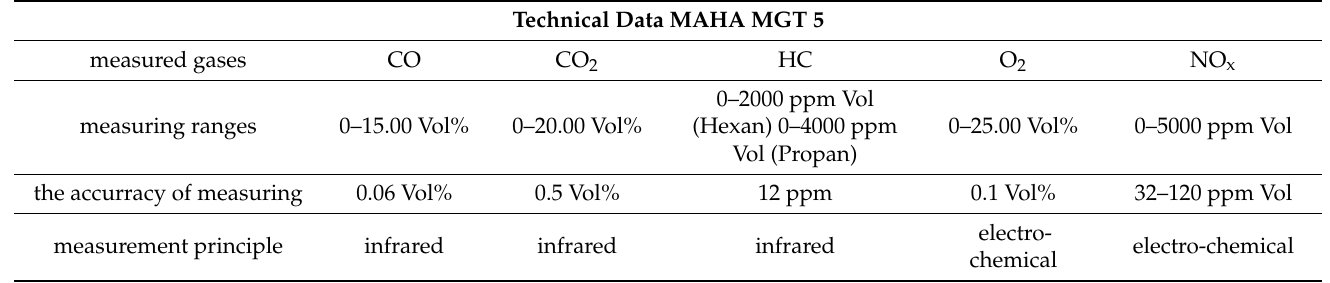
Table 3. Technical data MAHA MGT 5